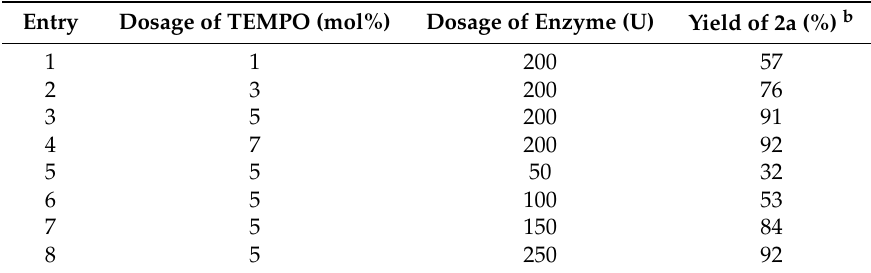
Table 3. The effect of dosage of TEMPO and lipase on the oxidation of salicyl alcohol. a